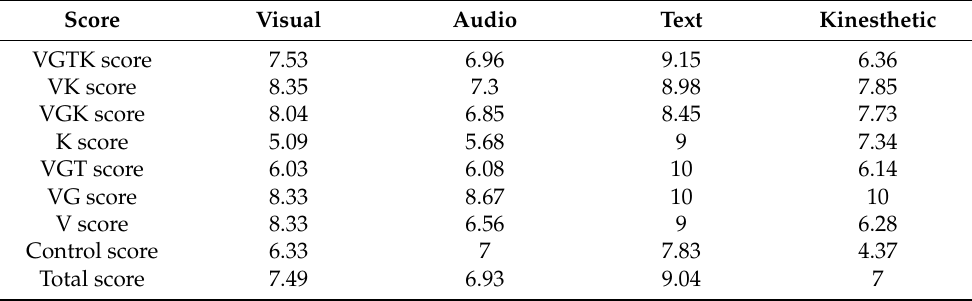
Table 3. Averages of the knowledge test results according to respondents’ potentially acceptable learning methods and forms of learning